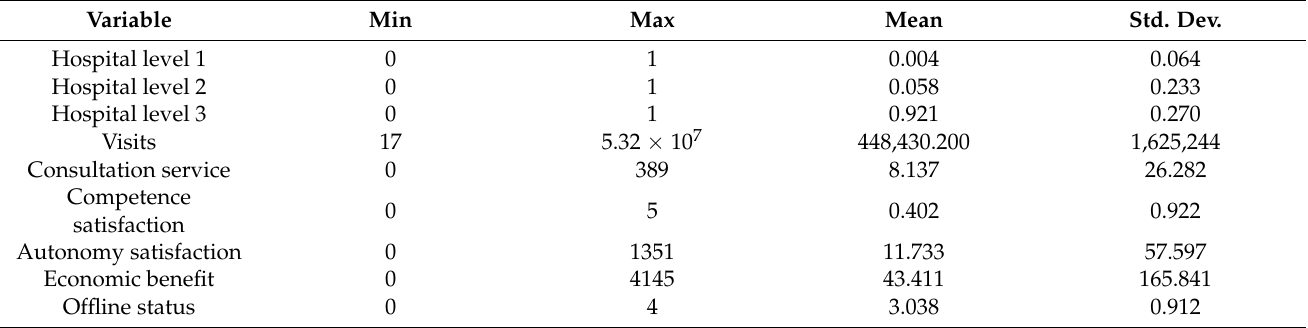
Table 2. Descriptive analysis of